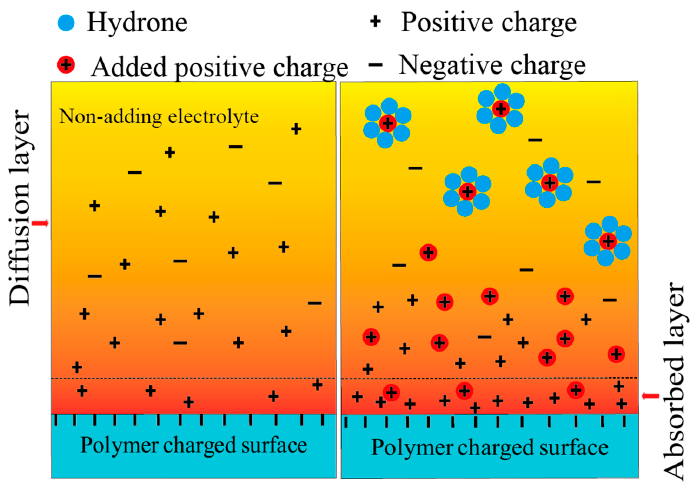
Figure 8. Compressing the thickness of the electric double layer of the polymer hydration shell.